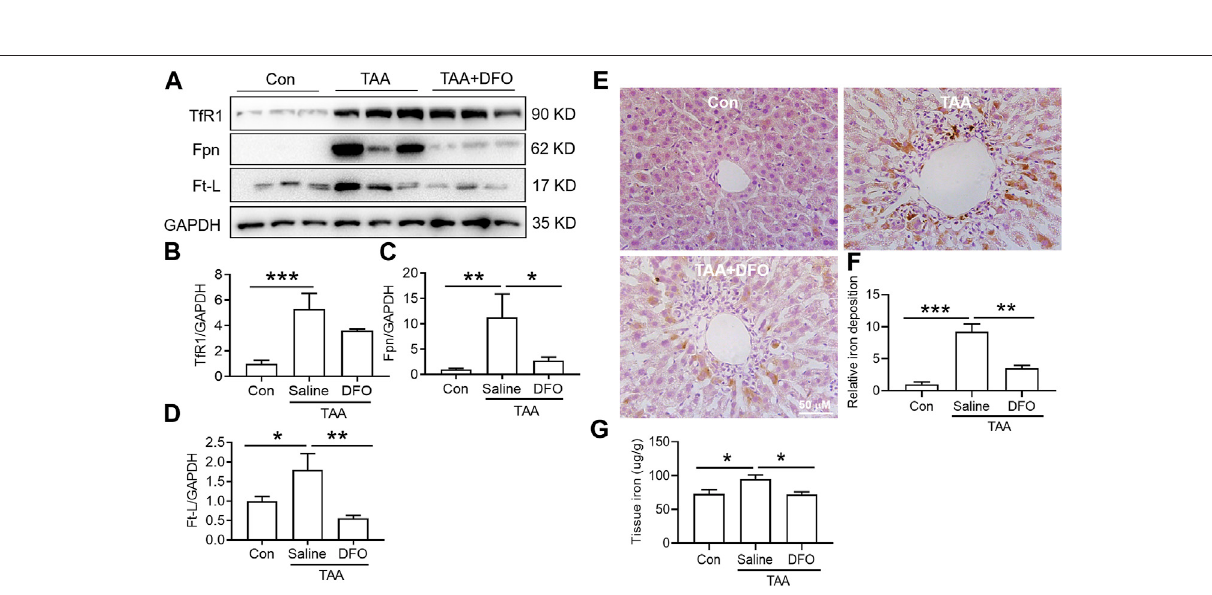
Frontiers in Pharmacology |